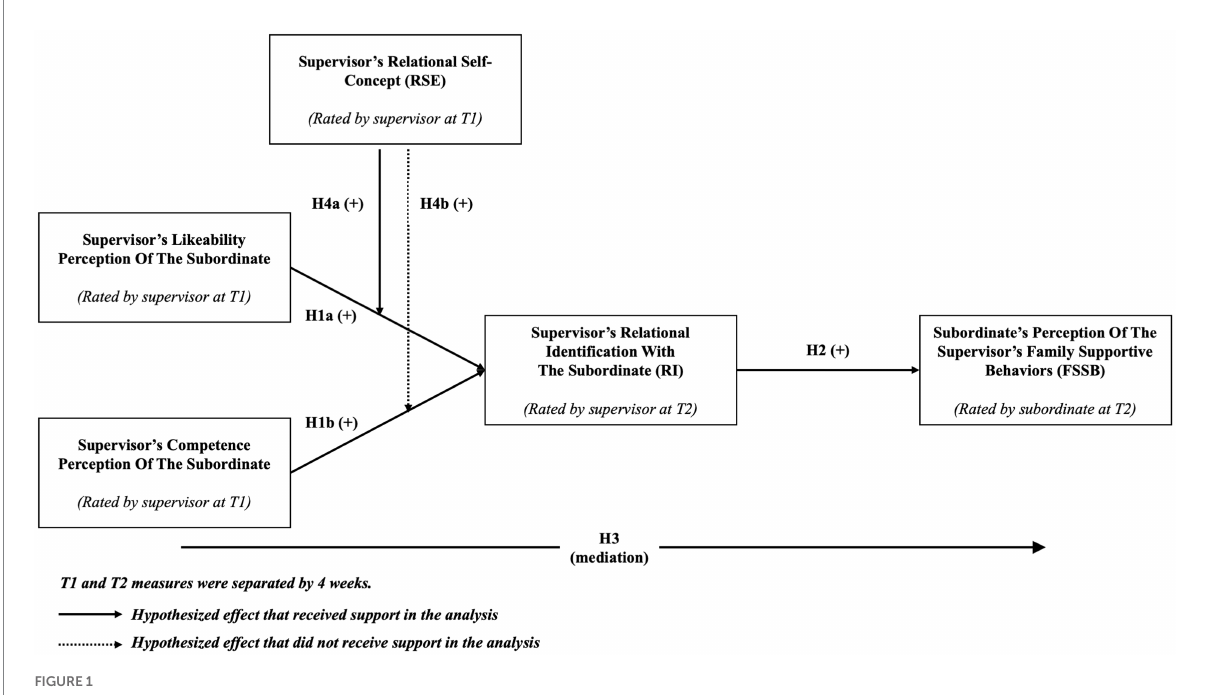
FIGURE 1 Hypothesized